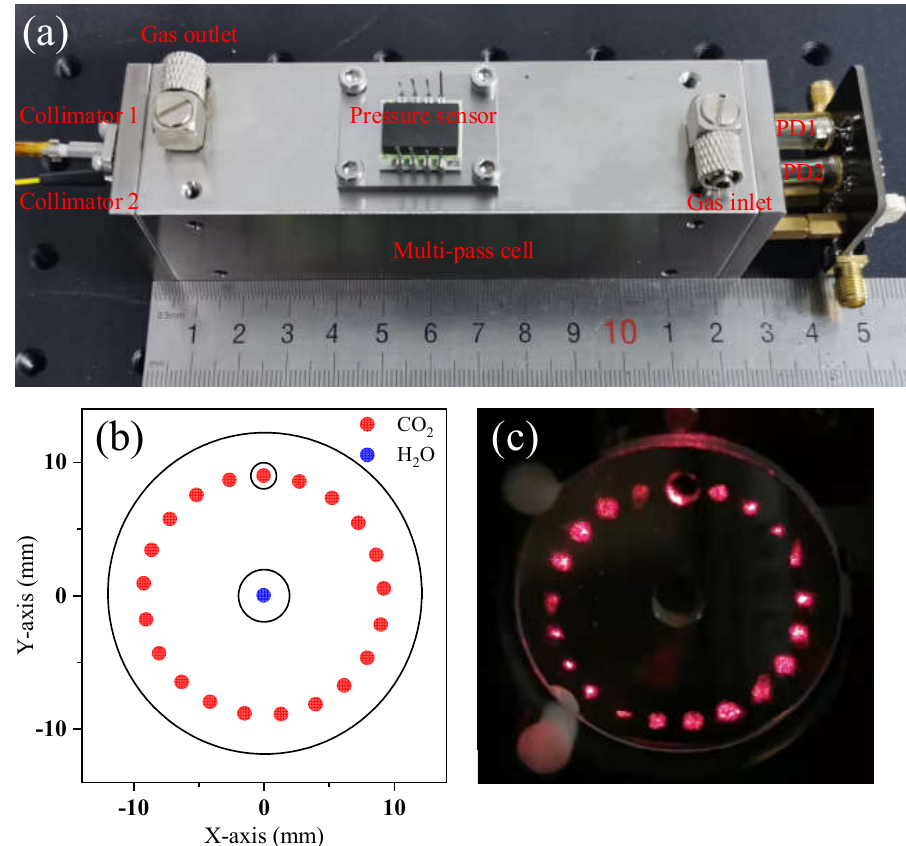
Figure 3. Homemade double light path miniaturized Herriott MPC, ( a ) photograph of the MPC structure, and ( b , c ) spot distribution on the simulation and mirrors, respectively.